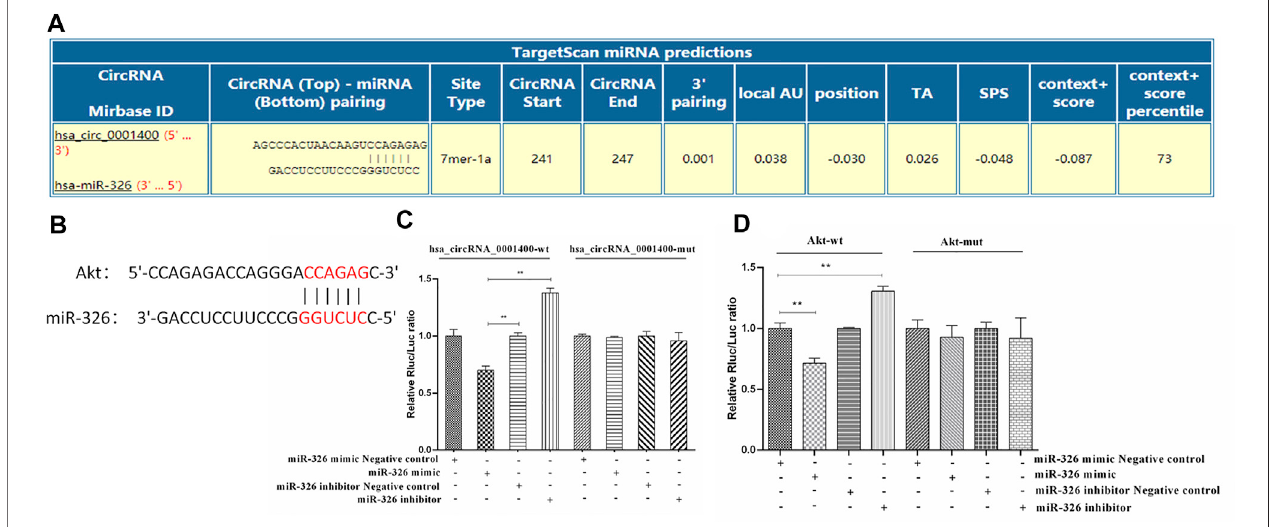
FIGURE 3 | Direct interaction of hsa-circRNA_0001400, miR-326, and Akt. (A) Bioinformatics prediction of the direct interaction sites of hsa_circRNA_0001400 and miR-326. (B) Bioinformatics prediction of the direct interaction of miR-326 and Akt. (C) The direct interaction between hsa_circRNA_0001400 and miR-326 was analyzedbydoubleluciferasereportergeneanalysis. (D) ThedirectinteractionbetweenmiR-326andAktwasanalyzedbydoubleluciferasereportergeneanalysis.Data are expressed as mean ± standard deviation, n (cid:2) 3, * p < 0.05 and * * p < 0.01 vs. control group.